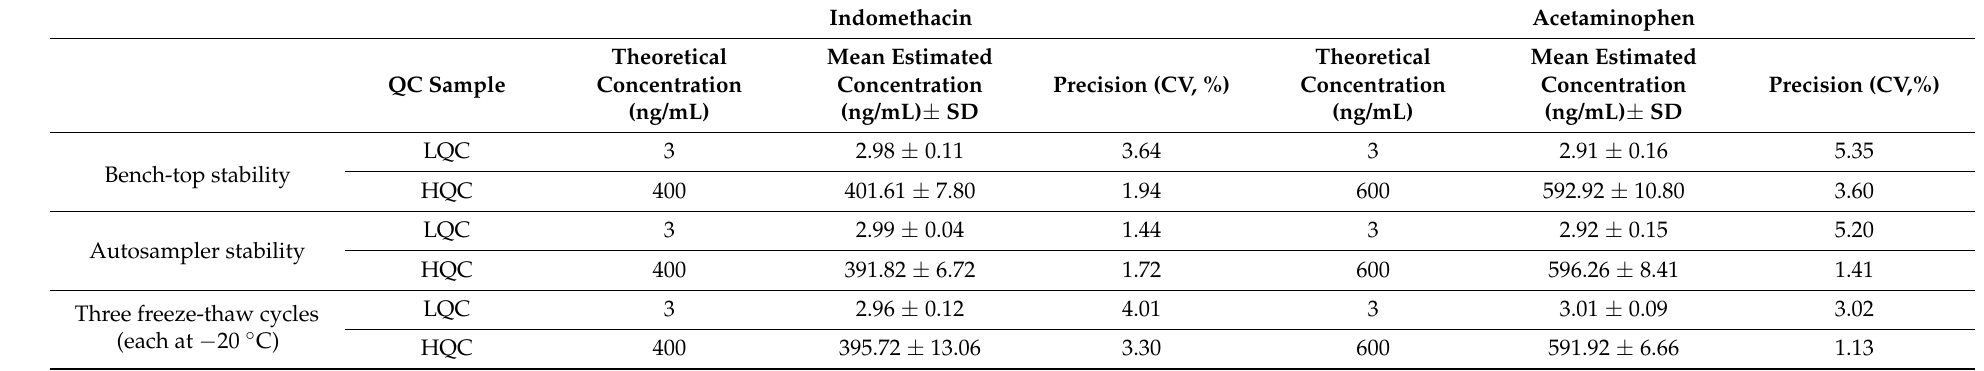
Table 3. Stability data of indomethacin and acetaminophen in rat plasma ( n =